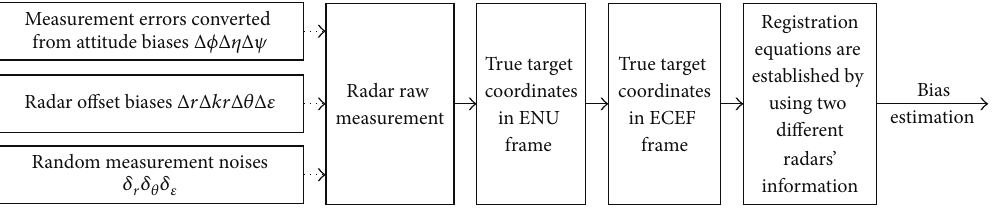
Figure 3: The flow chart for